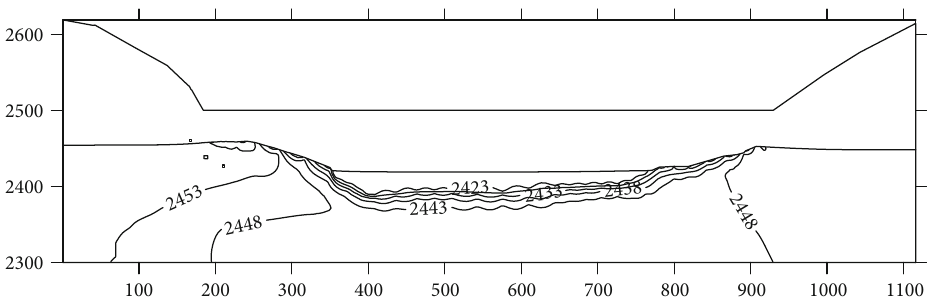
Figure 7: The isopotential distribution map of seepage fi eld about dam foundation (1-1 pro fi le).